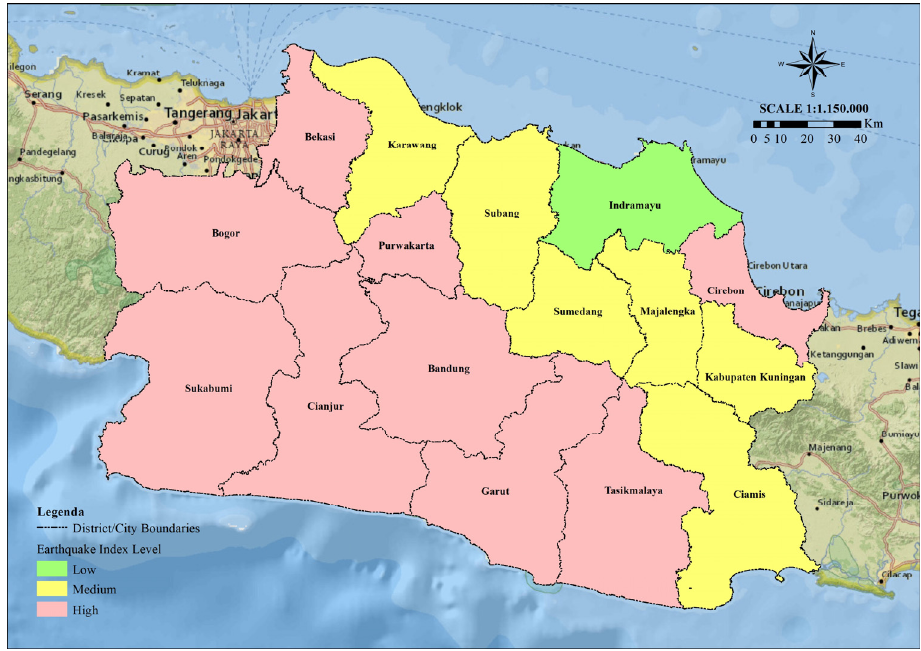
Figure 7. The final clustering using EDRI categories